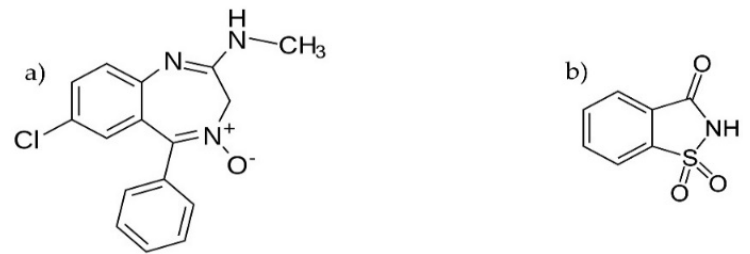
Figure 1. Formula of ( a ) chlordiazepoxide and ( b ) saccharin.